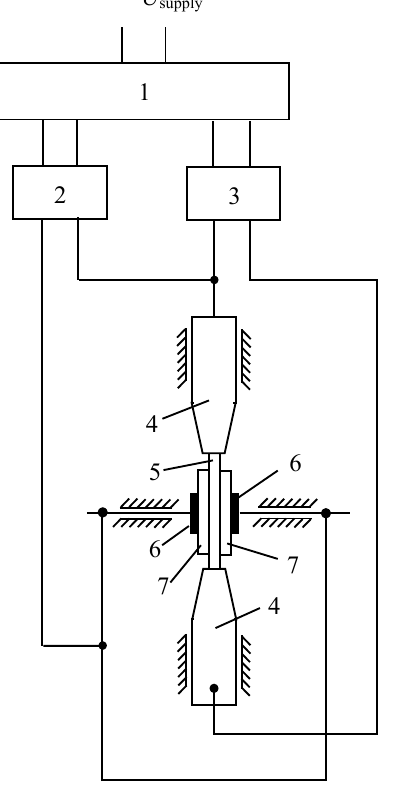
Fig. 2. Scheme of a device that implements the proposed solution.